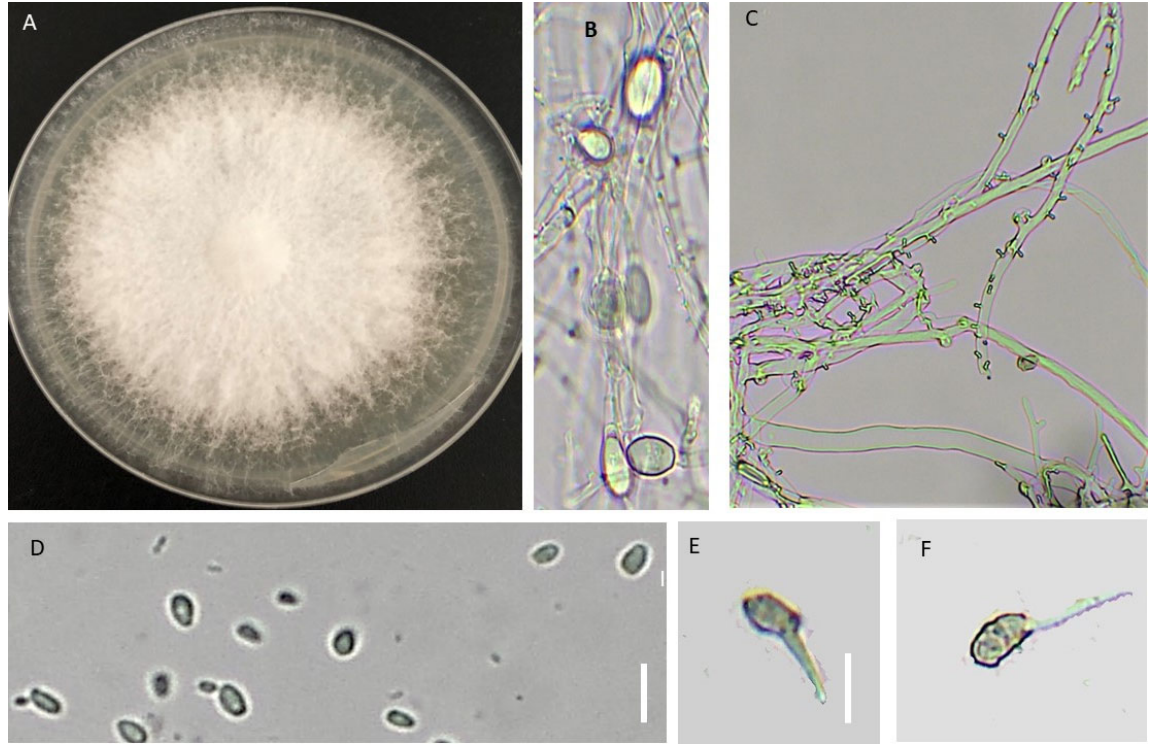
Figure 5. Morphological features of Chondrostereum purpureum . ( A ). Colony appearance on PDA; ( B ). Subhymenial hyphal ends; ( C ). Mycelium; ( D ). Conidia; ( E , F ). cystidia. Scale bar: ( C ) = 100 µ m; ( E ) = 10 µ m; ( E , F ) = 20 µ m.